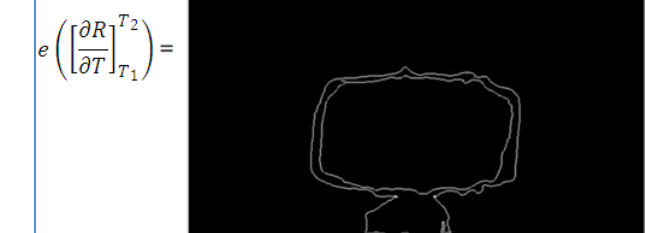
Figure 14. Temperature affected area at the critical tolerance level